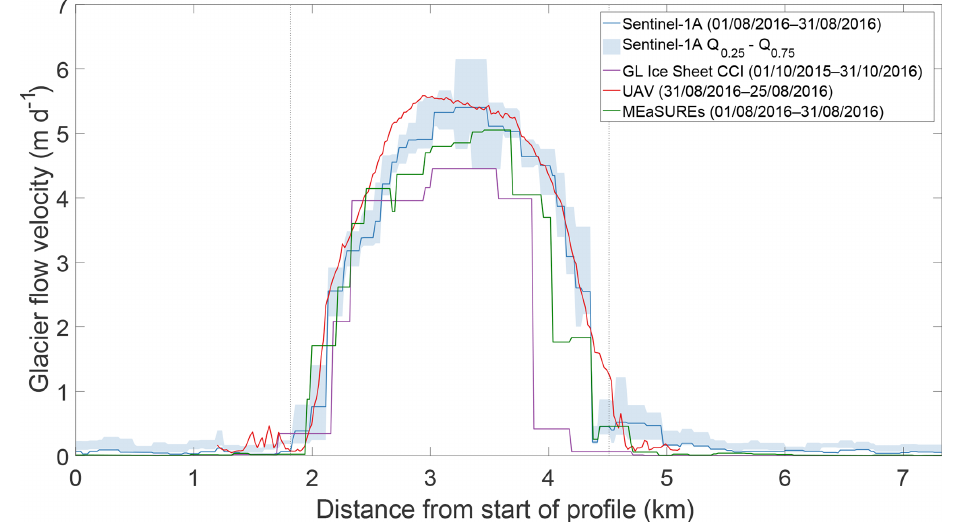
Figure A5. Mean flow speed across the glacier tongue (see Fig. 1) derived from S1A scenes acquired between 1 and 31 August 2016 (1 month), starting at the orographic left side of the glacier. The reference flow speed based on the 4d UAV mosaics acquired on 21 and 25 August 2016 is shown in red, and the flow velocities from MEaSUREs and Greenland Ice Sheet CCI products are shown in green and purple. The dashed lines depict the glacier’s margins.